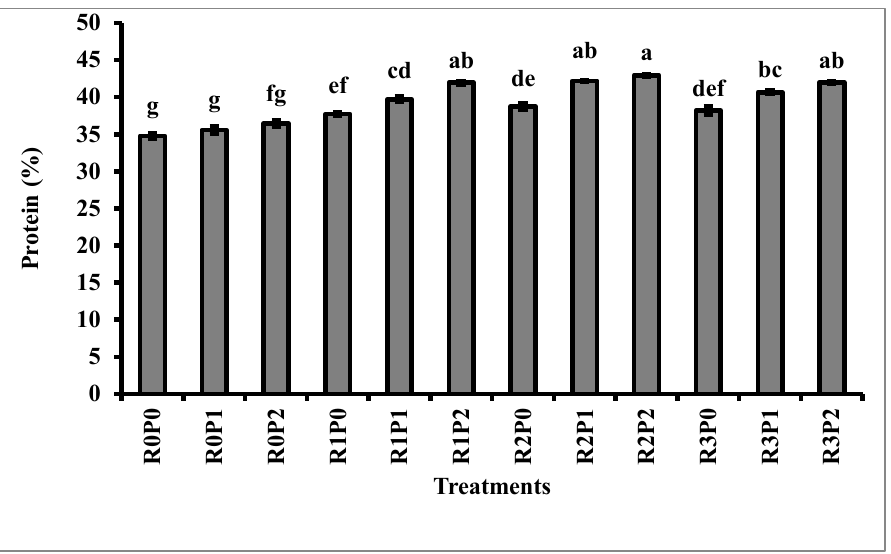
Figure 4. Interaction effect of Rhizobium japonicum and Pseudomonas striata on protein content of soybean. (mean ± SE, n = 3); R 0 : Control (no nitrogen and R. japonicum ), R 1 : 100% N without R. japonicum , R 2 : 50% N with R. japonicum , R 3 : only R. japonicum inoculant, P 0 : Control (no P and no P. striata ), P 1 : 100% P without P. striata and P 2 : 75% P with P. striata . Mean values sharing similar letters are statistically insignificant. Two-way ANOVA showed a significant interaction ( p ≤ 0.05) between R. japonicum and P. striata .